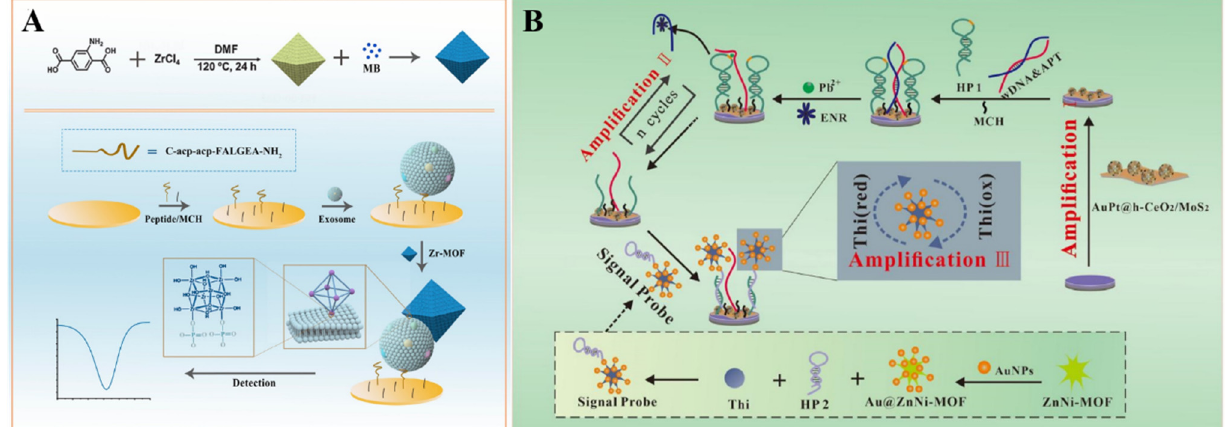
Figure 6. ( A ) Schematic illustration of the fabrication process of eMB@UiO-66-based nanoprobes and the principle of an electrochemical biosensor for the detection of GBM − derived exosomes. Reprinted with permission from Ref. [200]. Copyright 2021, American Chemical Society. ( B ) Schematic illustration of a Au@ZnNi − MOF − labeled electrochemical aptasensor for the detection of enrofloxacin. Reprinted with permission from Ref. [201]. Copyright 2022, Elsevier.